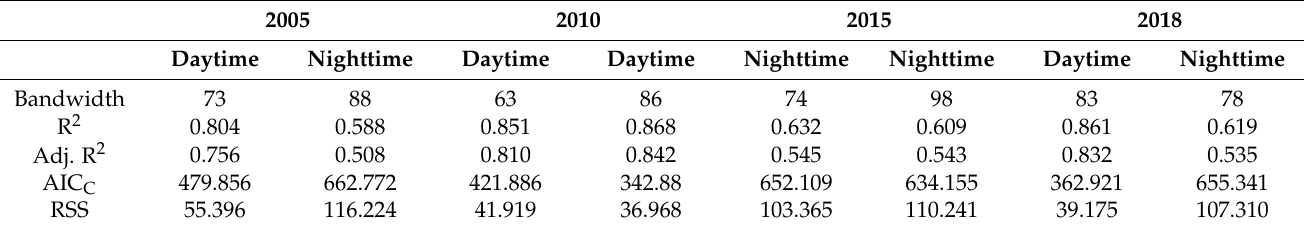
Table 4. Diagnostics information for the classical GWR model in each of the three time